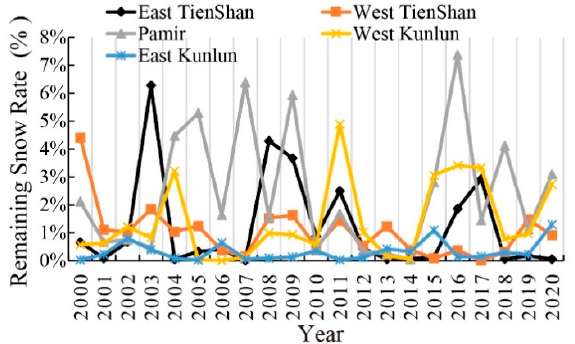
Figure 9. Mean monthly snow cover area in the five subregions of the Tarim Basin in the period of 2000–2020.